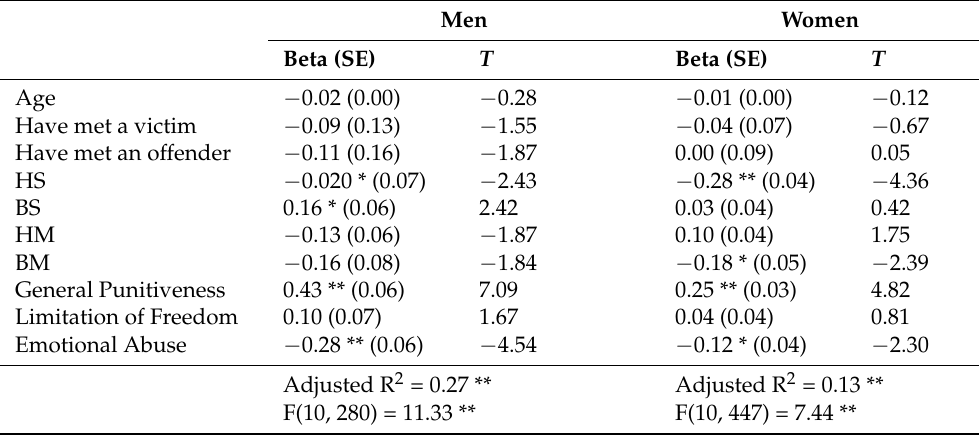
Table 5. Regression analyses predicting Risk